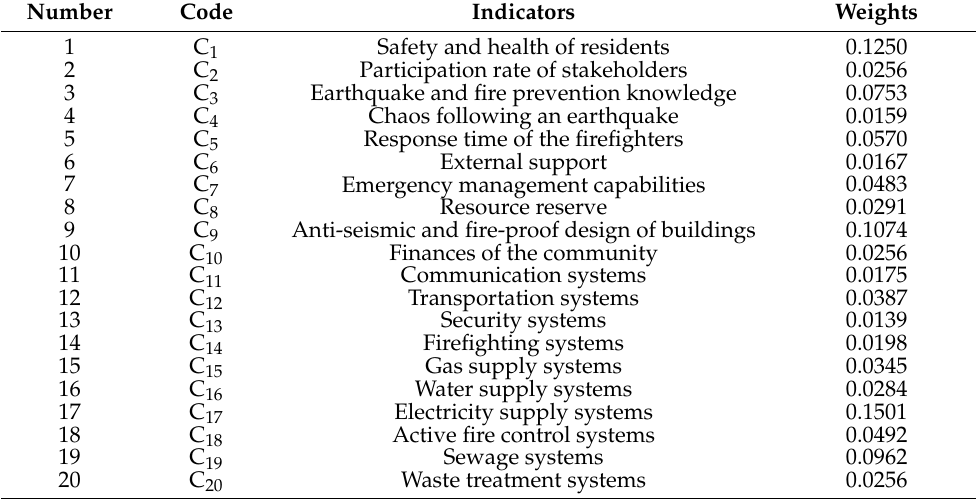
Table 5. Indicators and weights of community resilience adapted to FFE.